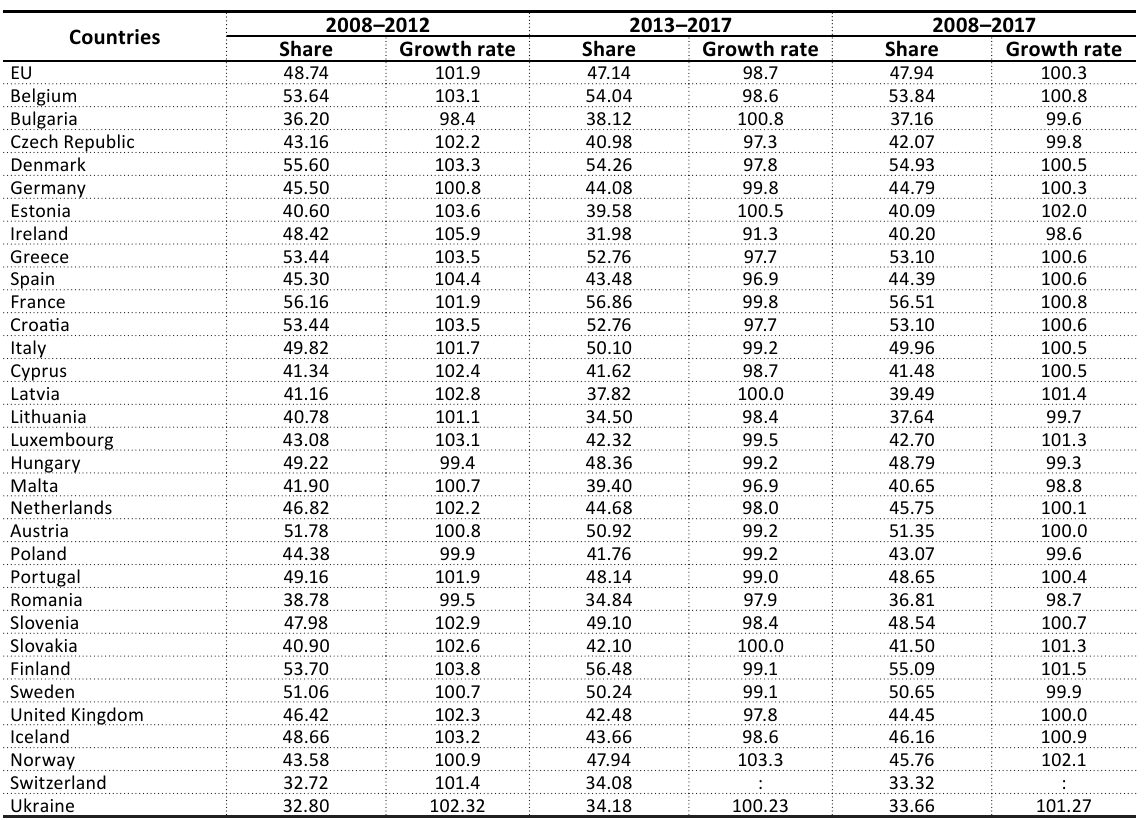
Table 1. Average growth rate and the share of government expenditures in GDP,